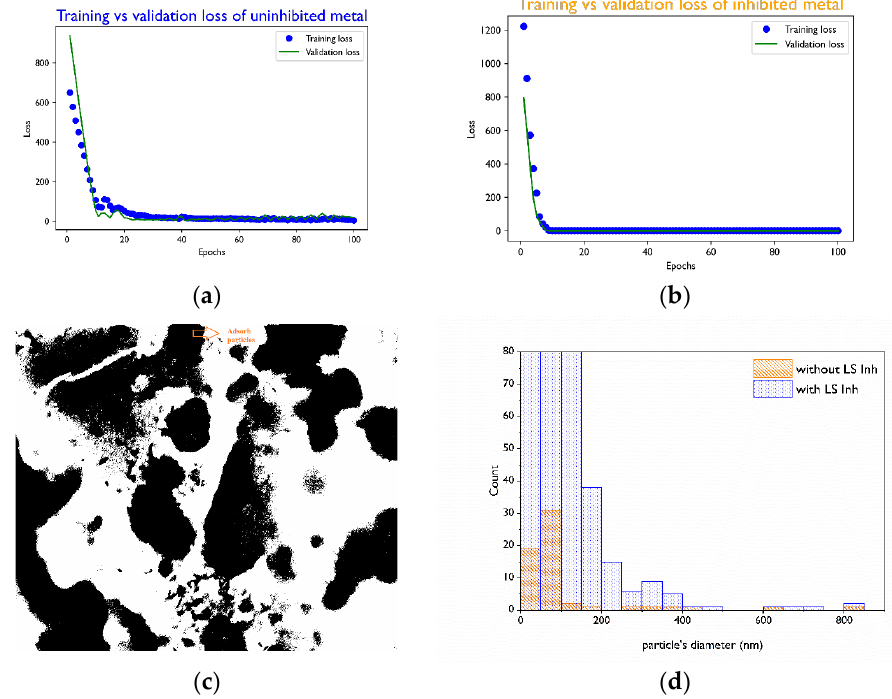
Figure 6. The ANN study and the diameters of adsorbed particles. ( a ) uninhibited metal; ( b ) inhibited metal; ( c ) distribution of adsorbed particles; ( d ) measured particle size before and after adsorption.